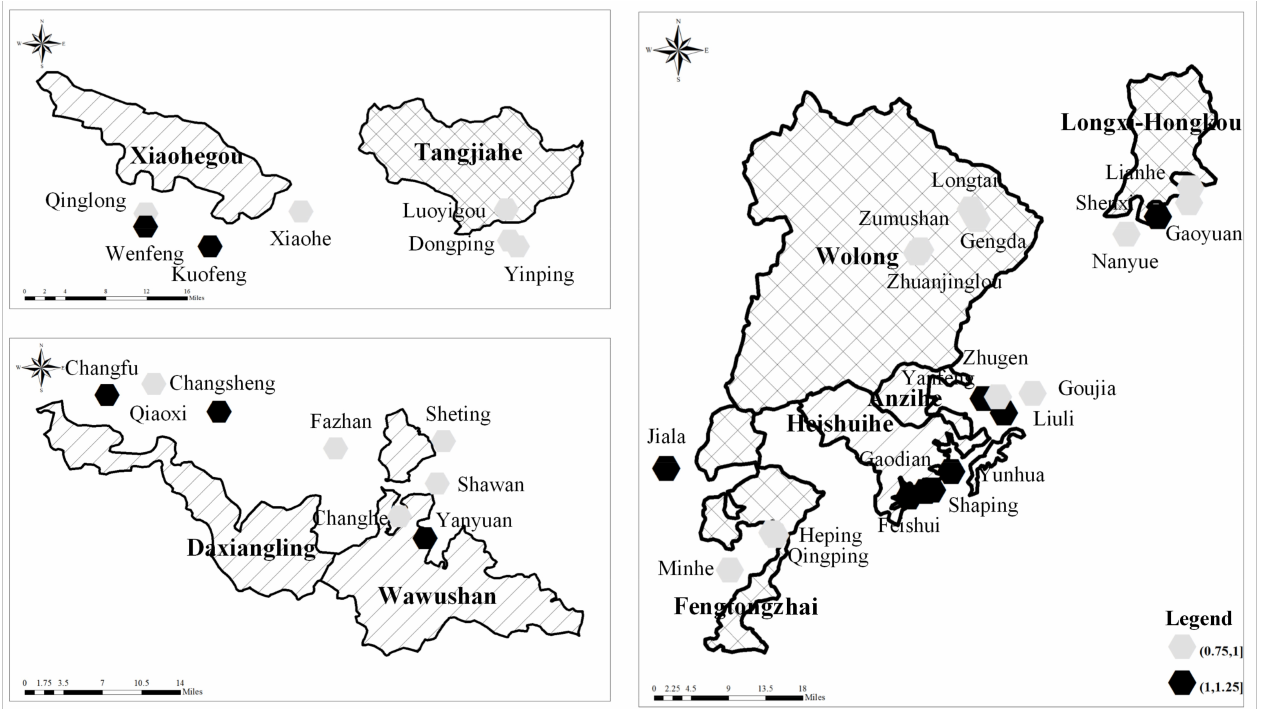
Figure 6. Comparison of ecological niche overlaps on the level of giant panda habitat under the labor force aging. Note: Comparison of ecological niche overlaps on the level of giant panda habitat = ecological niche overlap of OAG/Ecological Niche Overlap of YAG. Map Content Approval Number: CS (2019)